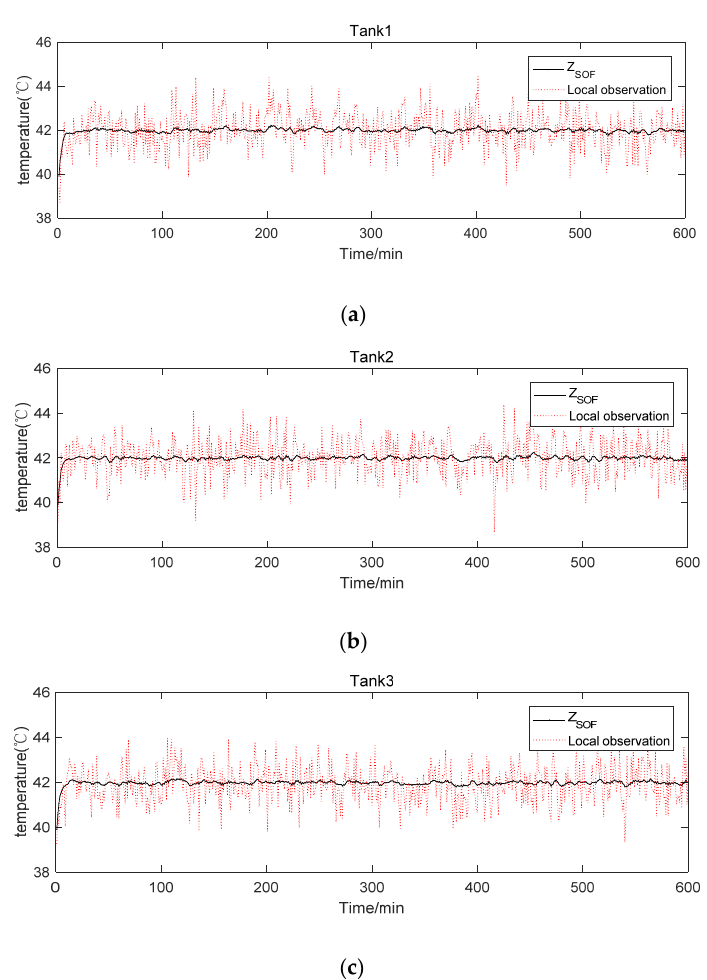
Figure 10. Comparison of simulation results between traditional and improved unscented Kalman filter (UKF) in ( a ) Tank1, ( b ) Tank2, and ( c ) Tank3.